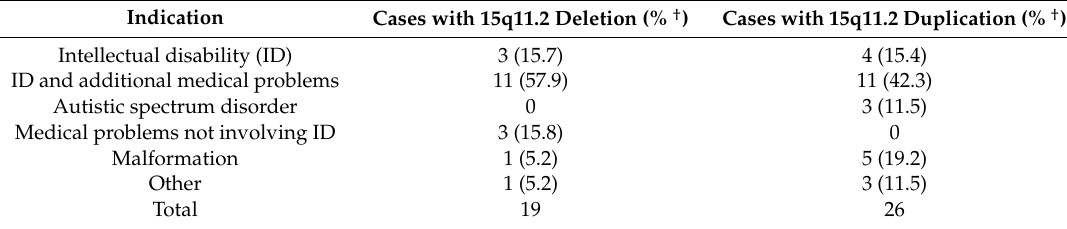
Table 4. Indications for CMA testing in postnatally detected 15q11.2 BP1-BP2 copy number